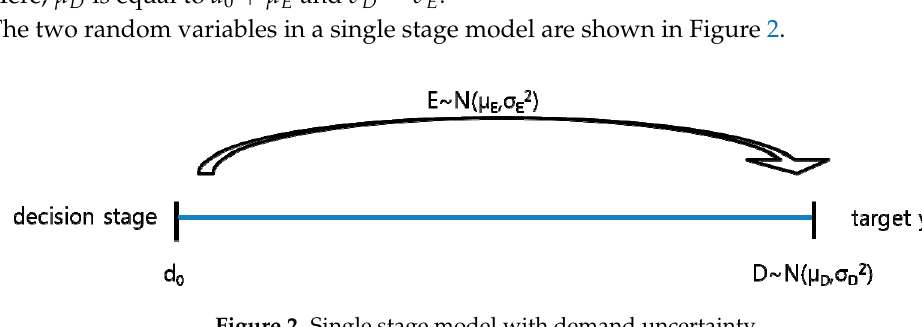
Figure 2. Single stage model with demand uncertainty.